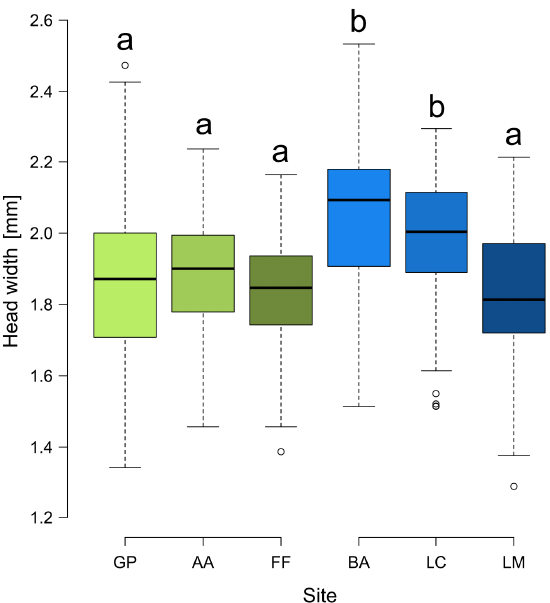
Figure 4. Boxplots of the head width of Formica paralugubris in the six sites. Letters above boxes summarize the results of Tukey ’ s multiple comparisons (boxes with the same letter indicate they are not significantly different from one another). Green and blue boxes represent populations derived from the Alpine sites of GP and BA, respectively. Shades of color represent the different populations and are the same of ellipses and symbols in the PLSDA projection (Figure 3). GP = Giovetto di Paline, AA = Avorniolo Alto; FF = Fosso Fresciaio; BA = Baradello; LC = Le Cullacce; LM = La Lama.